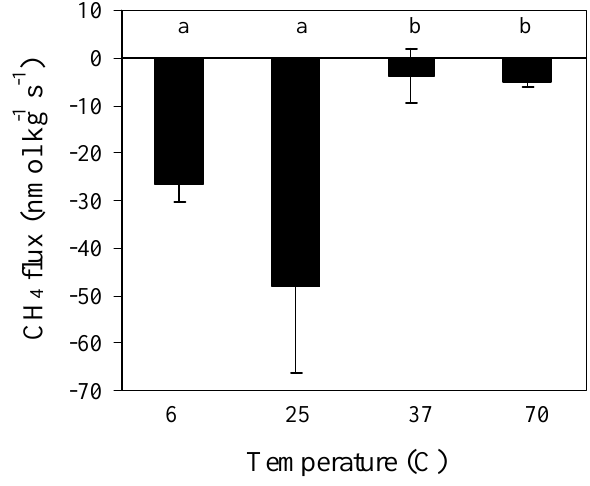
Fig. 3. Mean rates (N = 4) ± SE of CH 4 flux in anoxic peat incuba- tions at four different temperatures using a methanogenic inhibitor (BES). Negative values denote oxidation/consumption. Different letters are significantly different at p < 0 . 05